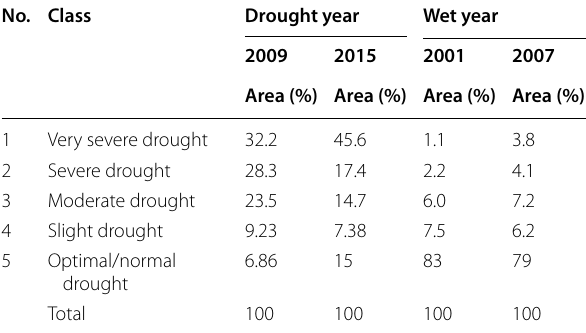
Table 4 Agricultural drought severity for drought year 2009 and 2015 and wet year 2001 and 2007 No.